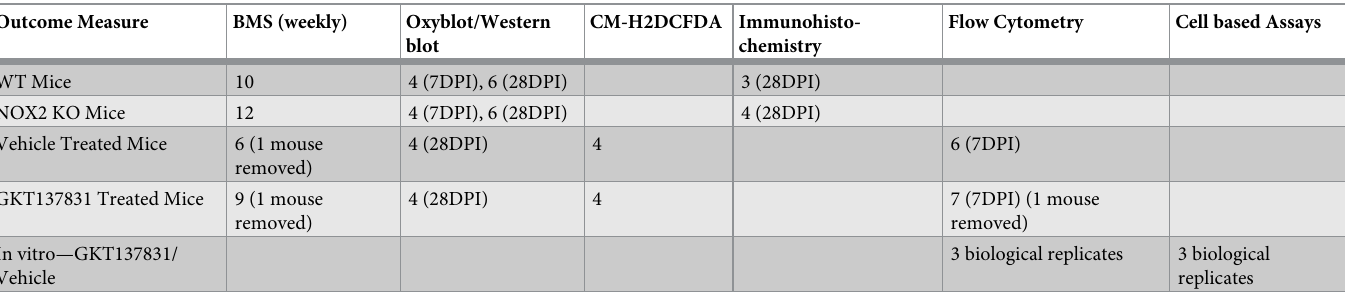
Table 1. Population and experimental groups per assay throughout the experimental design. Please note that due to the experimental design, in which treatment stud- ies were run in series rather than parallel, different outcome measures were utilized for NOX2 KO experiments in comparison to GKT137831 experiments. To help clarify animal and cell culture utilization, n for each outcome measure and time point is